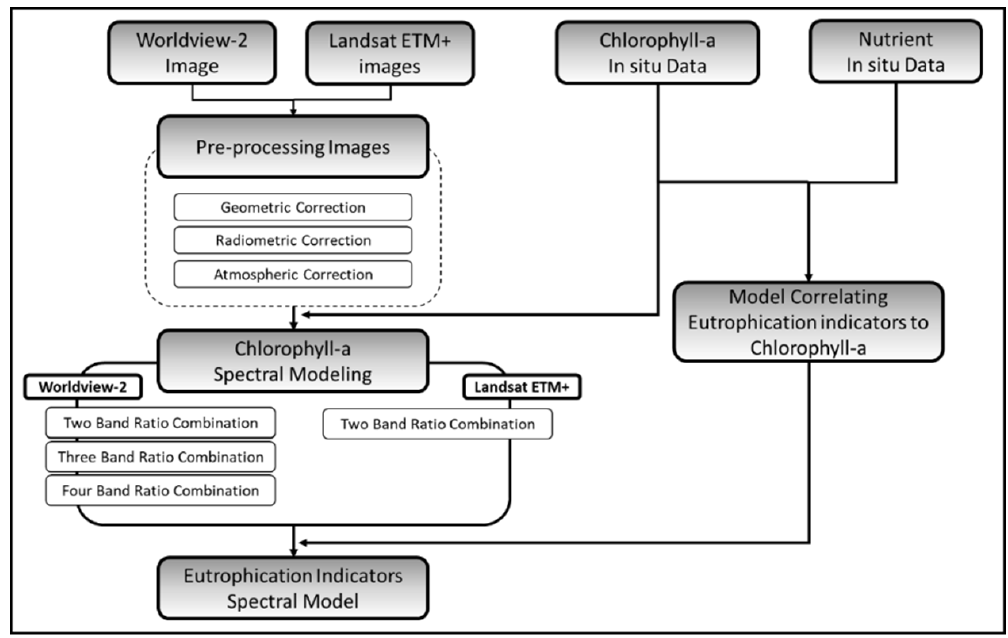
Figure 2. Main steps of the methodology.